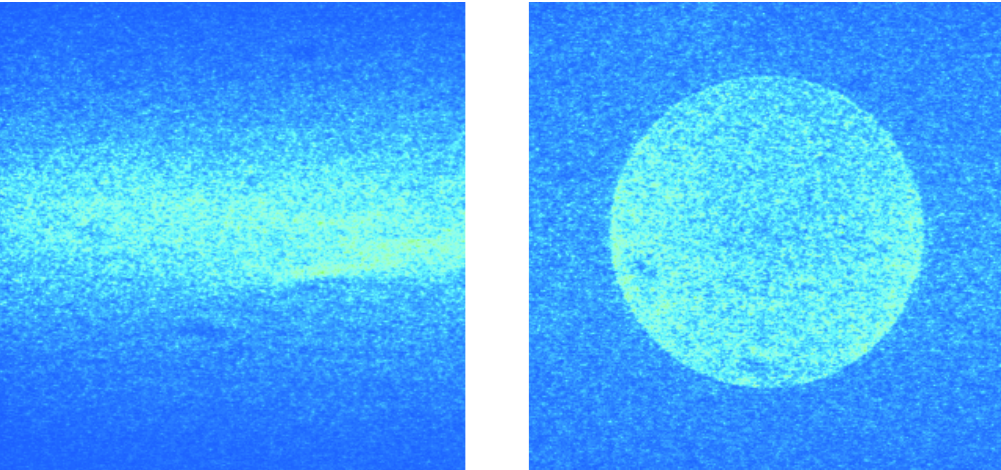
FIG. 5. (Color) (left) Image of the raw x-ray SR detected on the x-ray CCD. (right) Image of the CZP on the x-ray CCD after inserting the